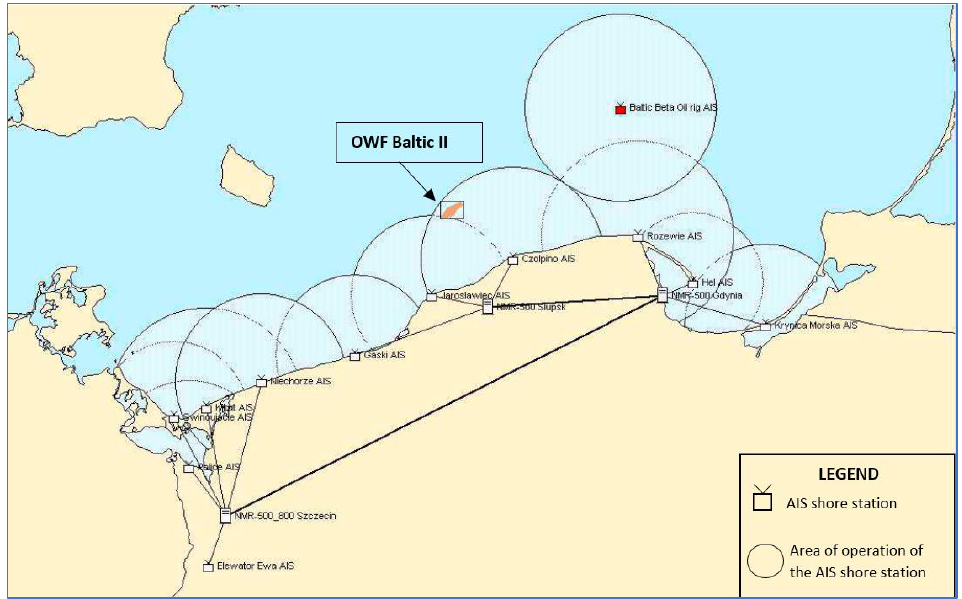
Figure 1. South Baltic with the coast of Poland [26].